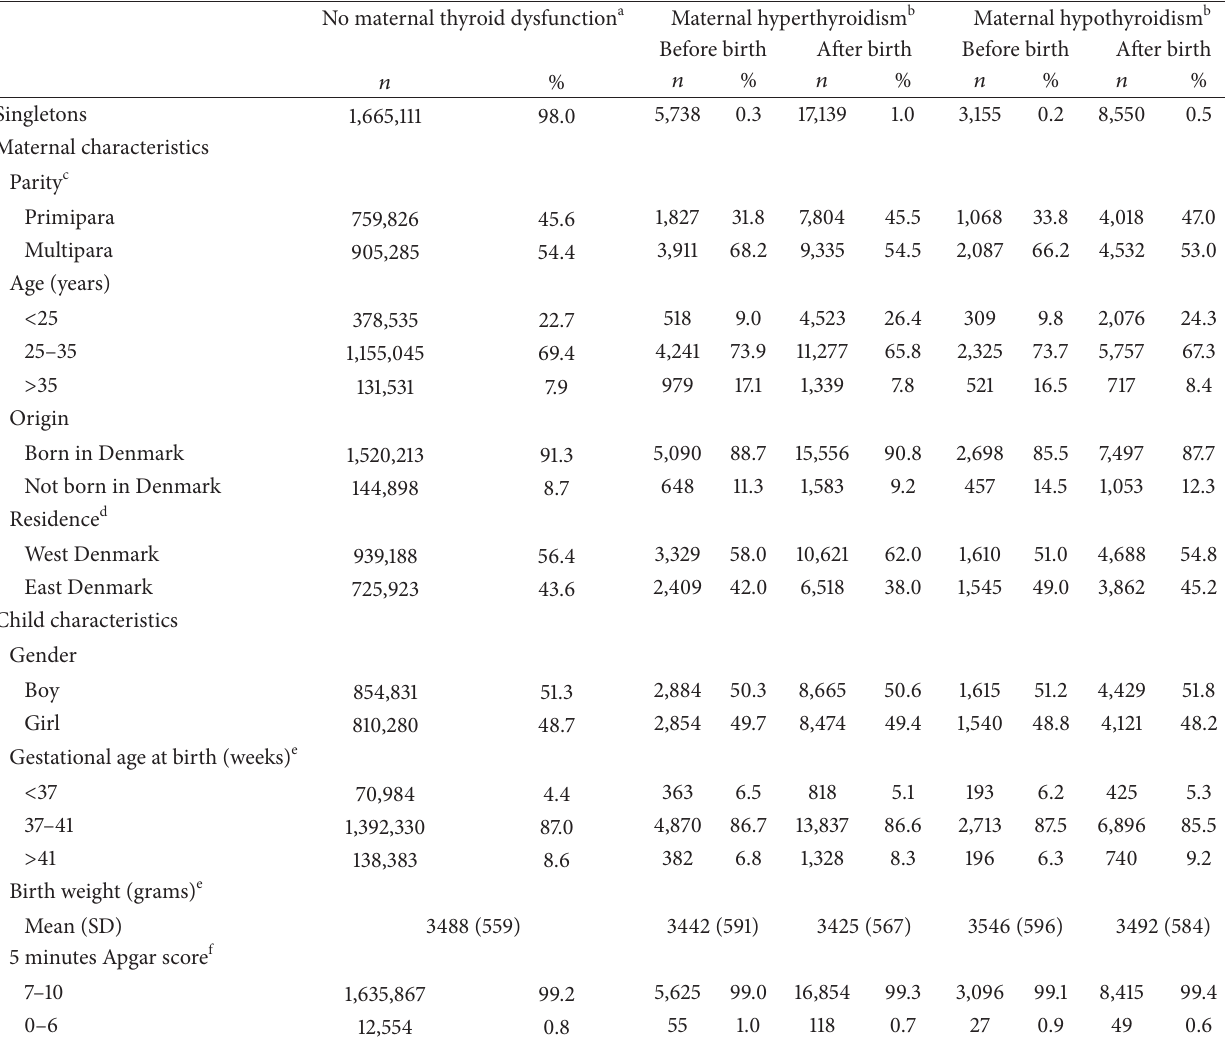
Table 1: Characteristics of singletons born in Denmark between January 1, 1978, and November 30, 2006, and their mothers at birth of the